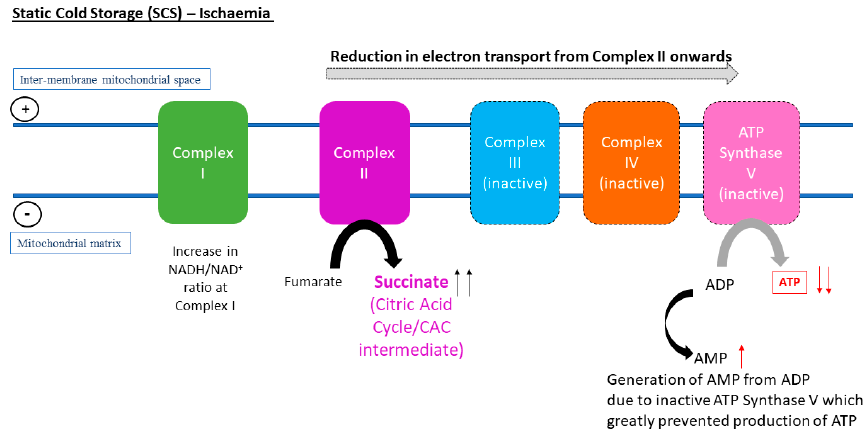
Figure 1. In vivo metabolomic analysis of murine liver and kidneys is associated with a conserved pathway that occurs during the state of ischaemia, which was the accumulation of succinate at Complex II in the electron transport chain.